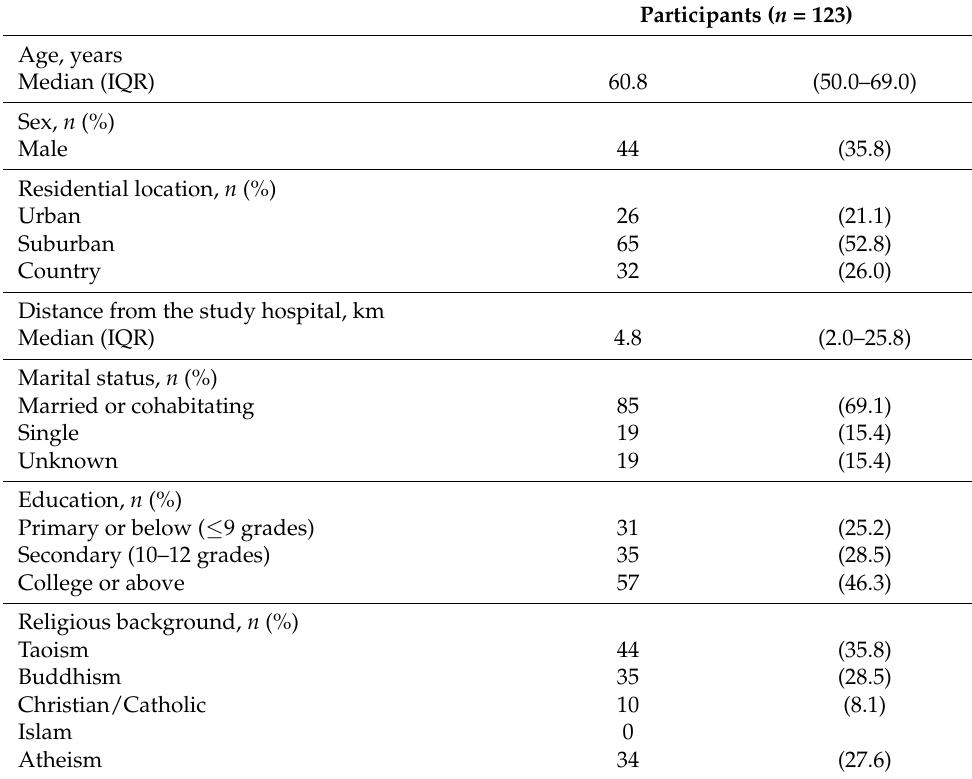
Figure 1. The flow diagram of the study. ACP, advance care planning; ADs, advance decisions. Table 1. Participant